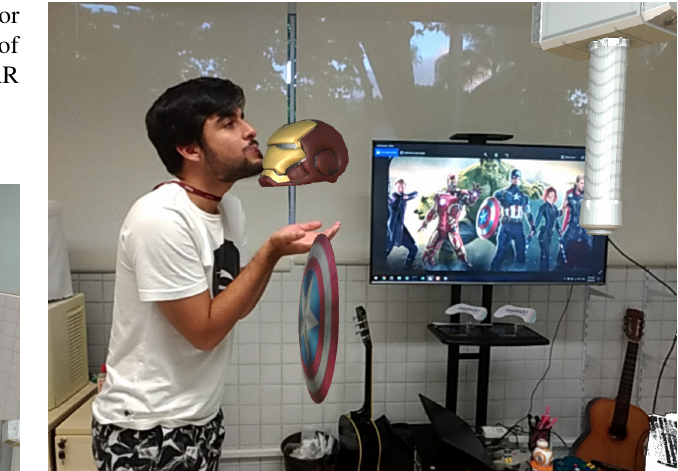
Figure 19. Picture taken by user with bad tracking result. It is possible to notice that the tracking is not accurate just by comparing the 3D position of the virtual objects relative to the TV.